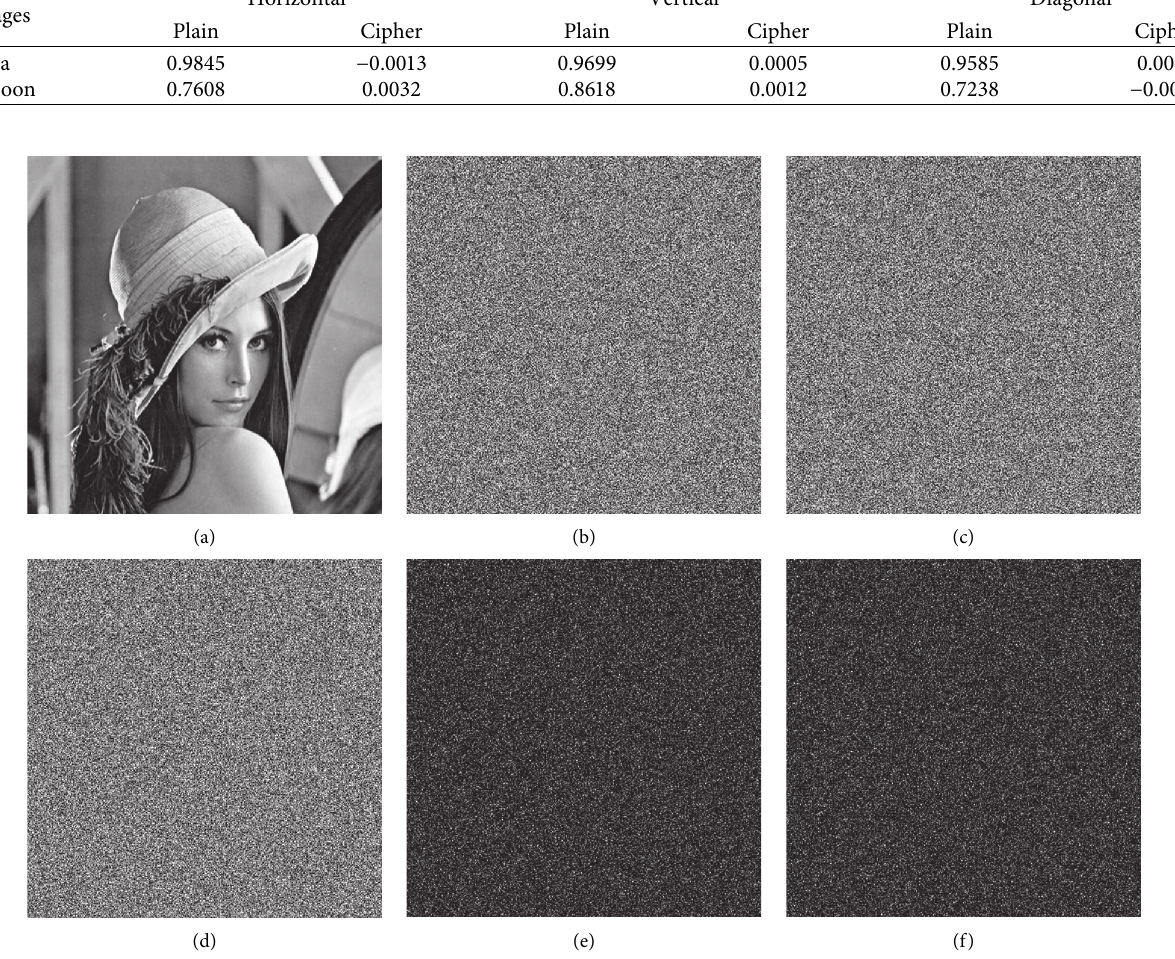
Figure 8: Key sensitivity analysis in encryption. (a) Original image. (b) Encrypted image with initial keys. (c) Encrypted image with